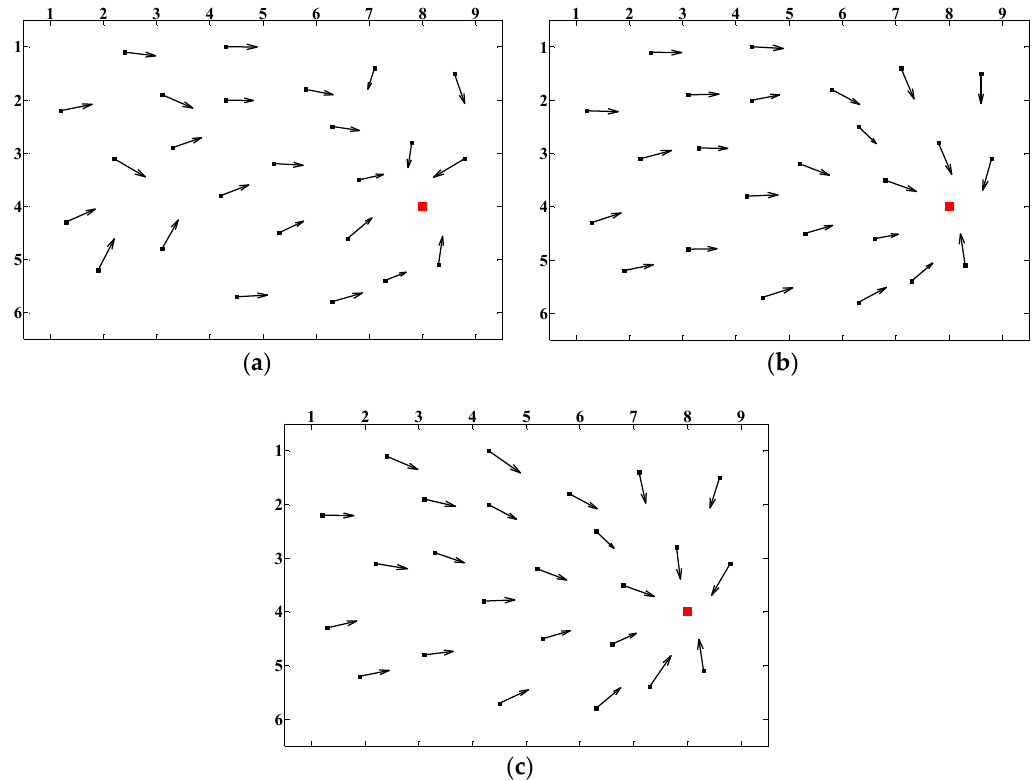
Figure 11. Homing vector fields (random spacing): ( a ) homing vector field of ALV; ( b ) homing vector field of SL-ALV; and ( c ) homing vector field of the proposed strategies.